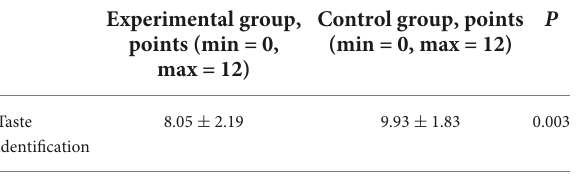
TABLE 4 The mean scores of taste identification.